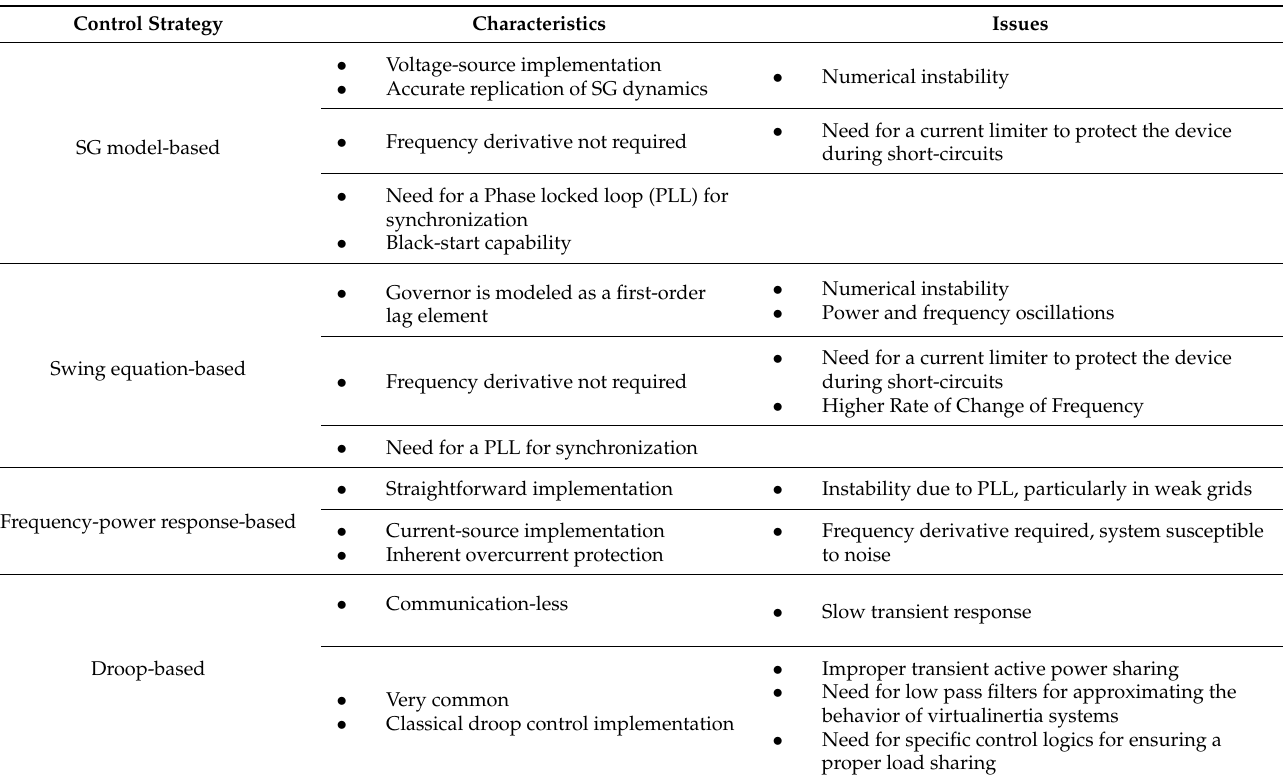
Table 1. Features and concerns of different VSM control strategies (built starting from [8]). Control Strategy